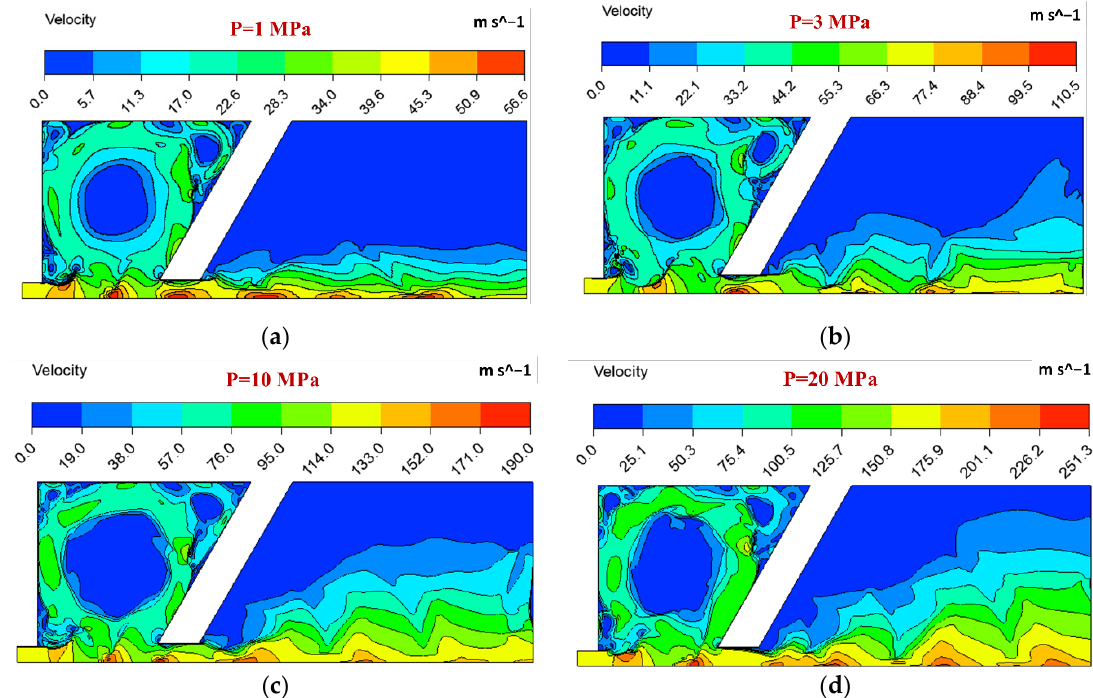
Figure 22. Velocity contours of the nozzle at different inlet pressures. ( a ) P = 1 MPa ( b ) P = 3 MPa ( c ) P = 10 MPa and ( d ) P = 20 MPa.